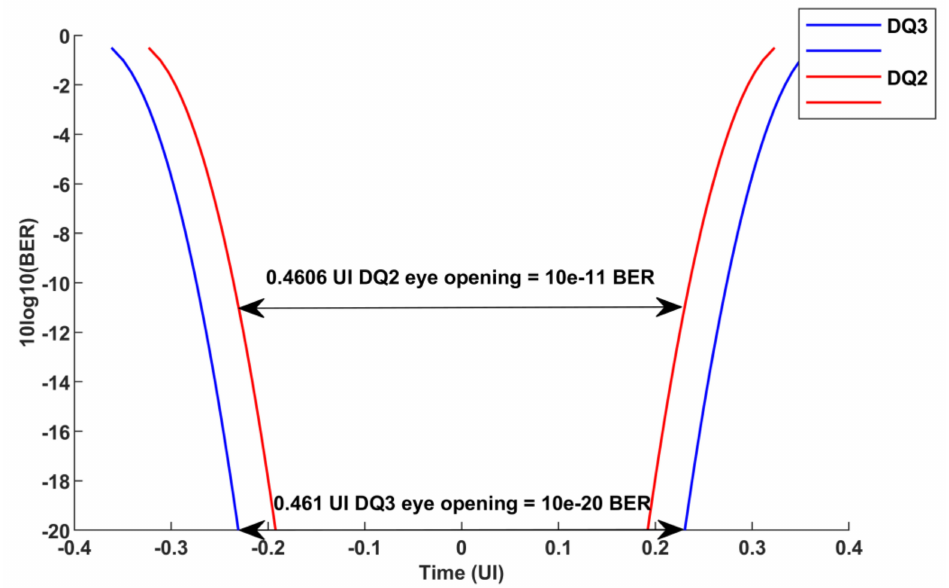
Figure 13. Bathtub plots for DQ2 (crack defect in solder ball) and DQ3 (no defect) data